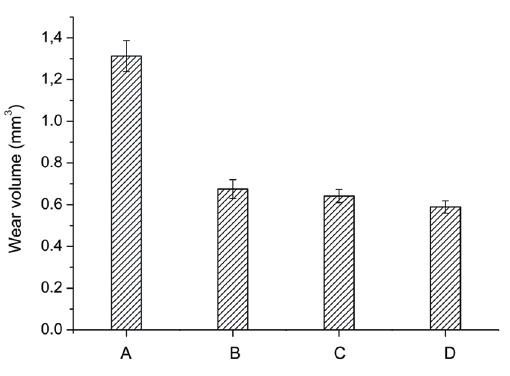
Figure 8: Wear volume. A - Heat treatment, B – Chromizing, C – Chrome-boronizing-siliconizing (obtained using mixture 2) and D - Chrome-boronizing-siliconizing (obtained using mixture